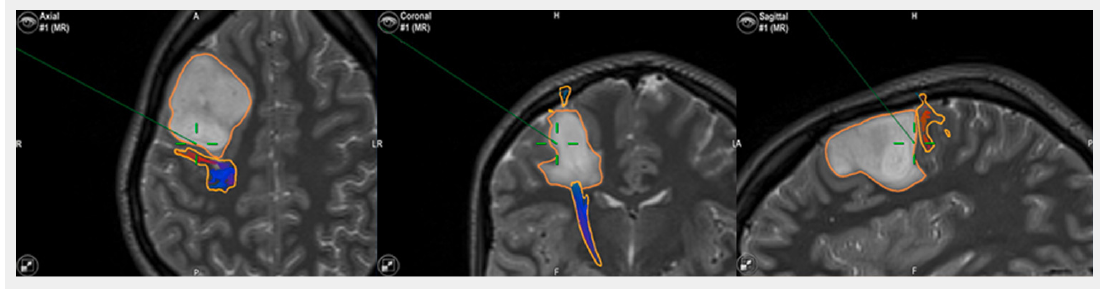
Figure 2 Neuronavigation allows correlation of any intra-operative point with the pre-operative MRI. Intraoperative neuronavigation facilitates spatial orientation during surgery at the crucial interface between a low-grade glioma (hyper-intense), the primary motor cortex (red) and the corticospinal tract